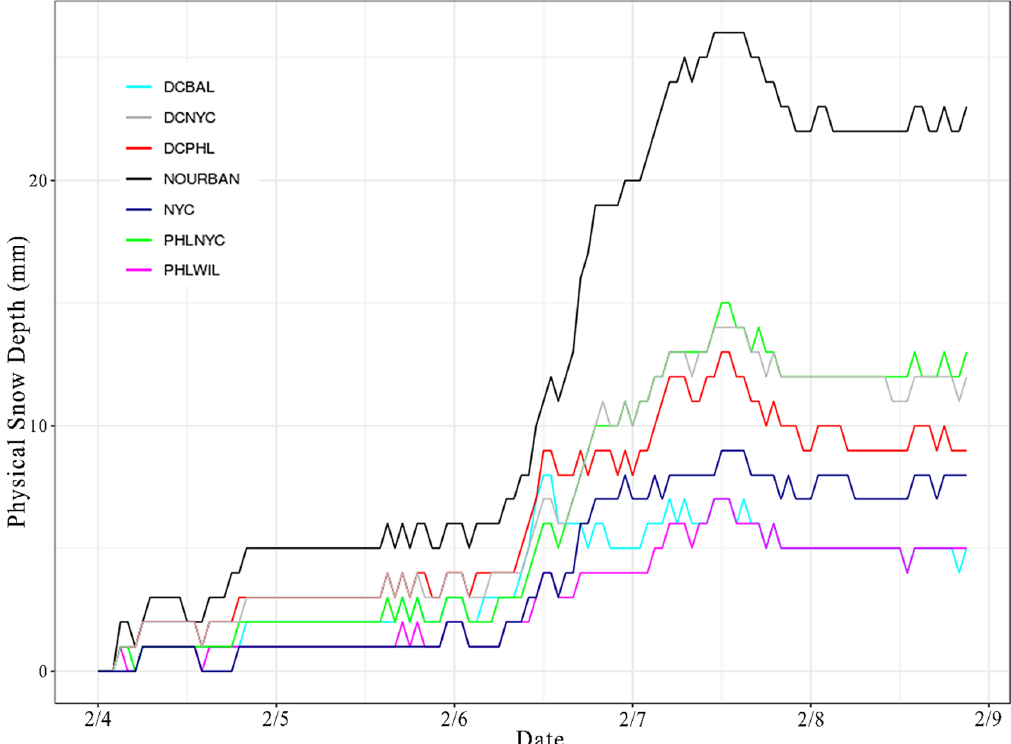
Figure 7. WRF-simulated snow depth difference from the control ( SnowDepth modified − SnowDepth control ) over the masked urban grid points. Valid from 0000 UTC on 4 February to 2300 UTC on 8 February 2004.